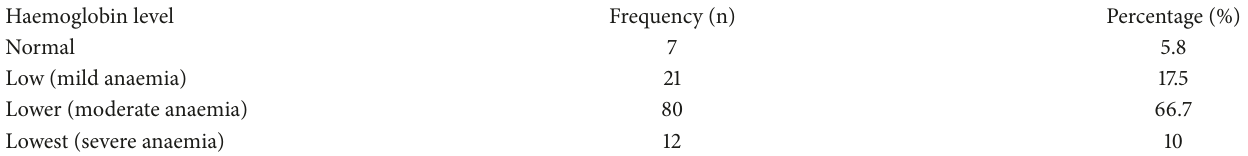
Table 4: The distribution of haemoglobin concentration of the